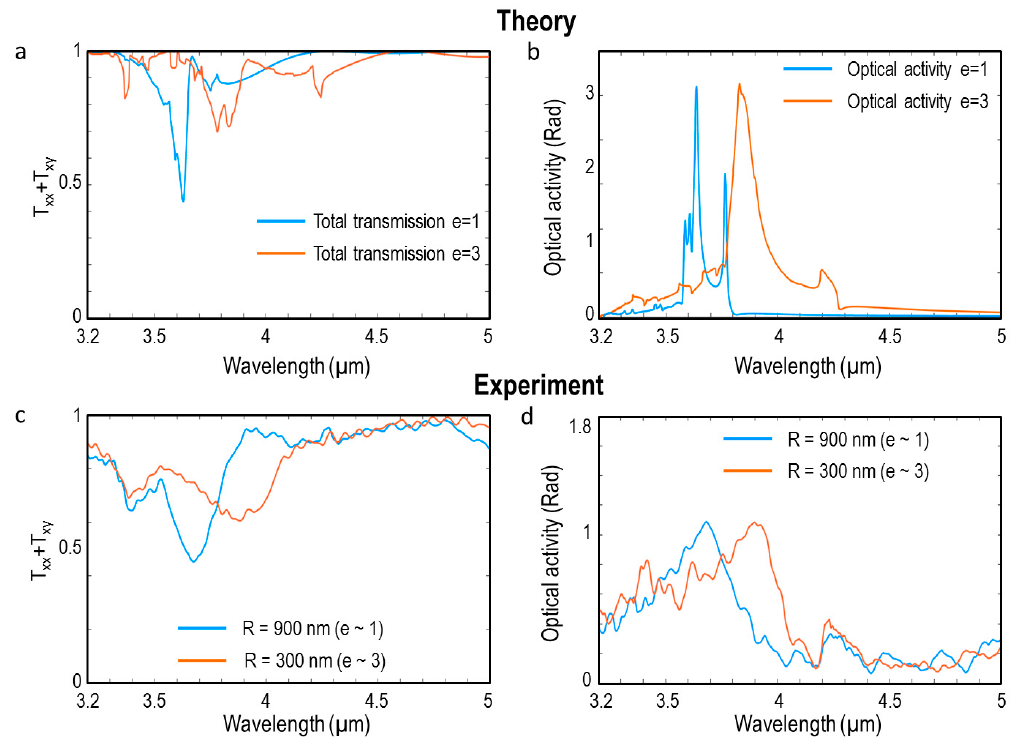
Figure 5. Comparison of experimental and theoretical results. ( a ) Theoretical transmission and ( b ) theoretical OA calculated for 8-srs PhCs with lattice constant of 3.5 µ m and rod diameter of 550 nm for aspect ratio e = 1 (blue) and e = 3 (orange). ( c ) Experimental transmission and ( d ) experimental OA for 8-srs PhC fabricated via GD-DLW with different GD radius (R): 900 nm (e~1) (blue) and 300 nm (e~3) (orange).